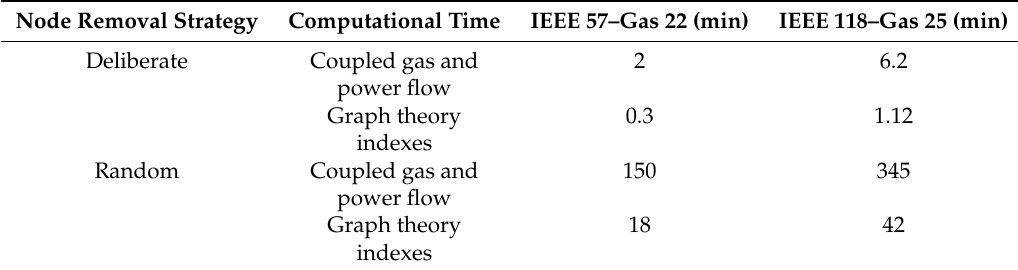
Table 2. Computation time of the algorithm of Figure